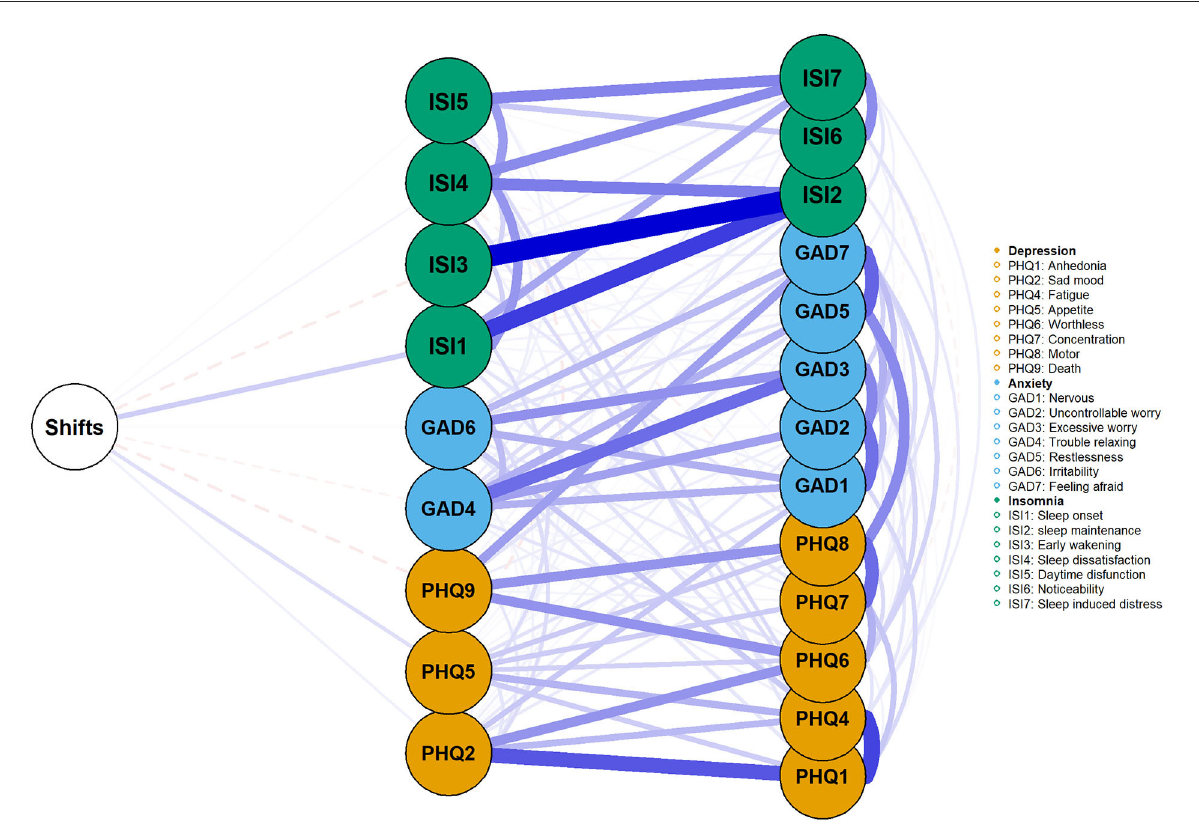
FIGURE4 The impact of night shifts on insomnia, depression, and anxiety symptoms. The green, blue, and orange nodes represented insomnia, anxiety, and depression symptoms, respectively. The blue edges represented positive association, while the red represented the negative association. Thicker edges suggested stronger